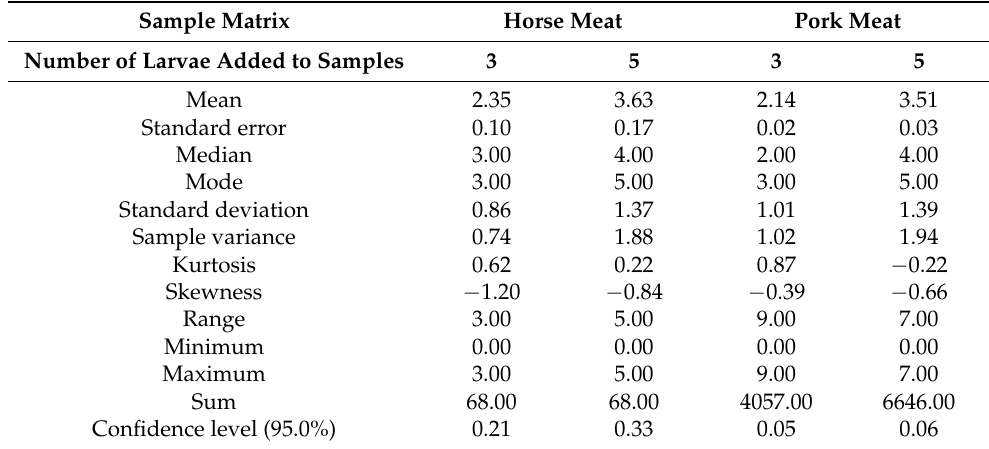
Table 10. Comparison of descriptive statistic parameters for horse and pork meat analysis. Sample Matrix